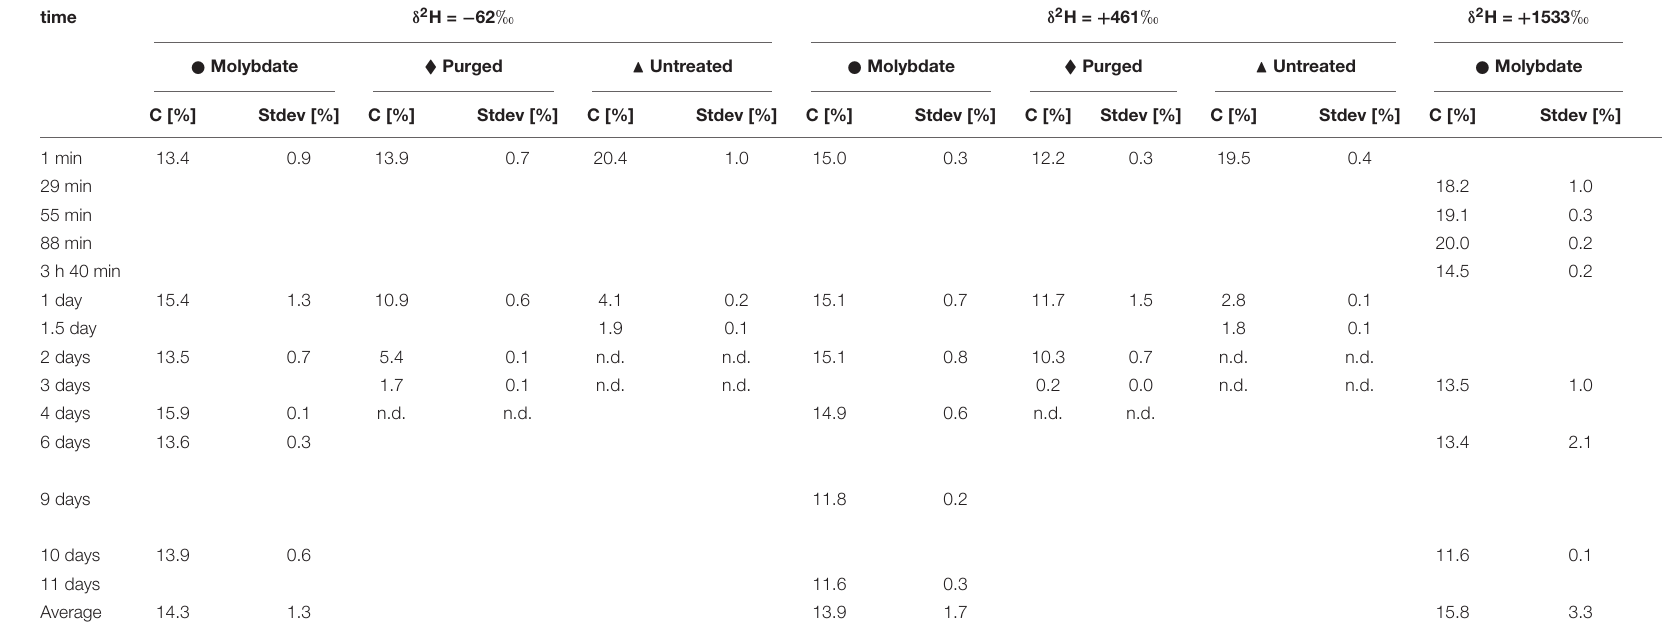
TABLE 1 | Concentration of H 2 in all experimental setups: molybdate-inhibited, headspace purged with N 2 to reduce sulfides and without additional treatment.